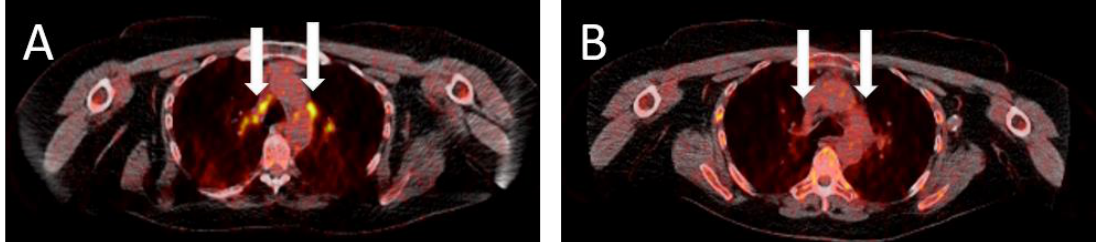
Figure 1. FDG-PET-CT scans of a patient with stage-IV cutaneous melanoma ( A , B ). The lymph node metastases showed a complete metabolic response following treatment with combined immunotherapy of ipilimumab 3 mg/kg and nivolumab 1 mg/kg every 3 weeks. ( A ) shows the metastases at the start of immunotherapy. ( B ) shows the same location after 2 administration cycles. Arrows indicate the location of the (former, B ) metastases.